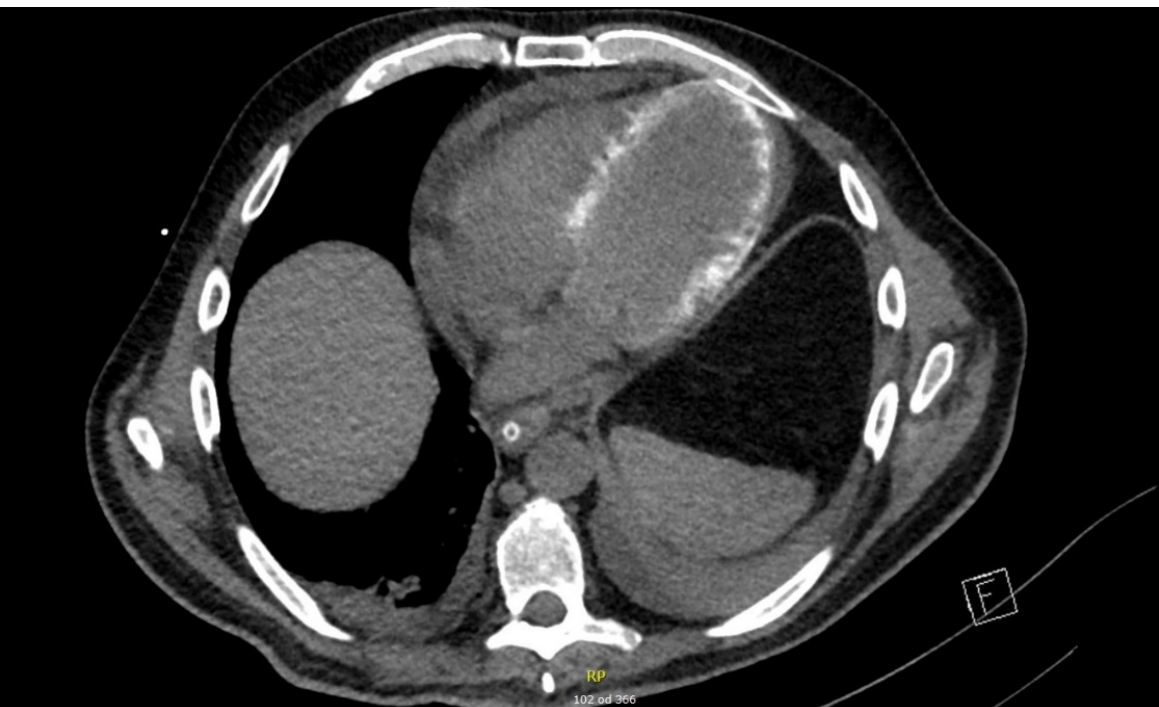
Figure 2. Cardiac CT scan with diffuse myocardial calcinations and pericardial effusion, performed on day 20 of ICU treatment (axial image).